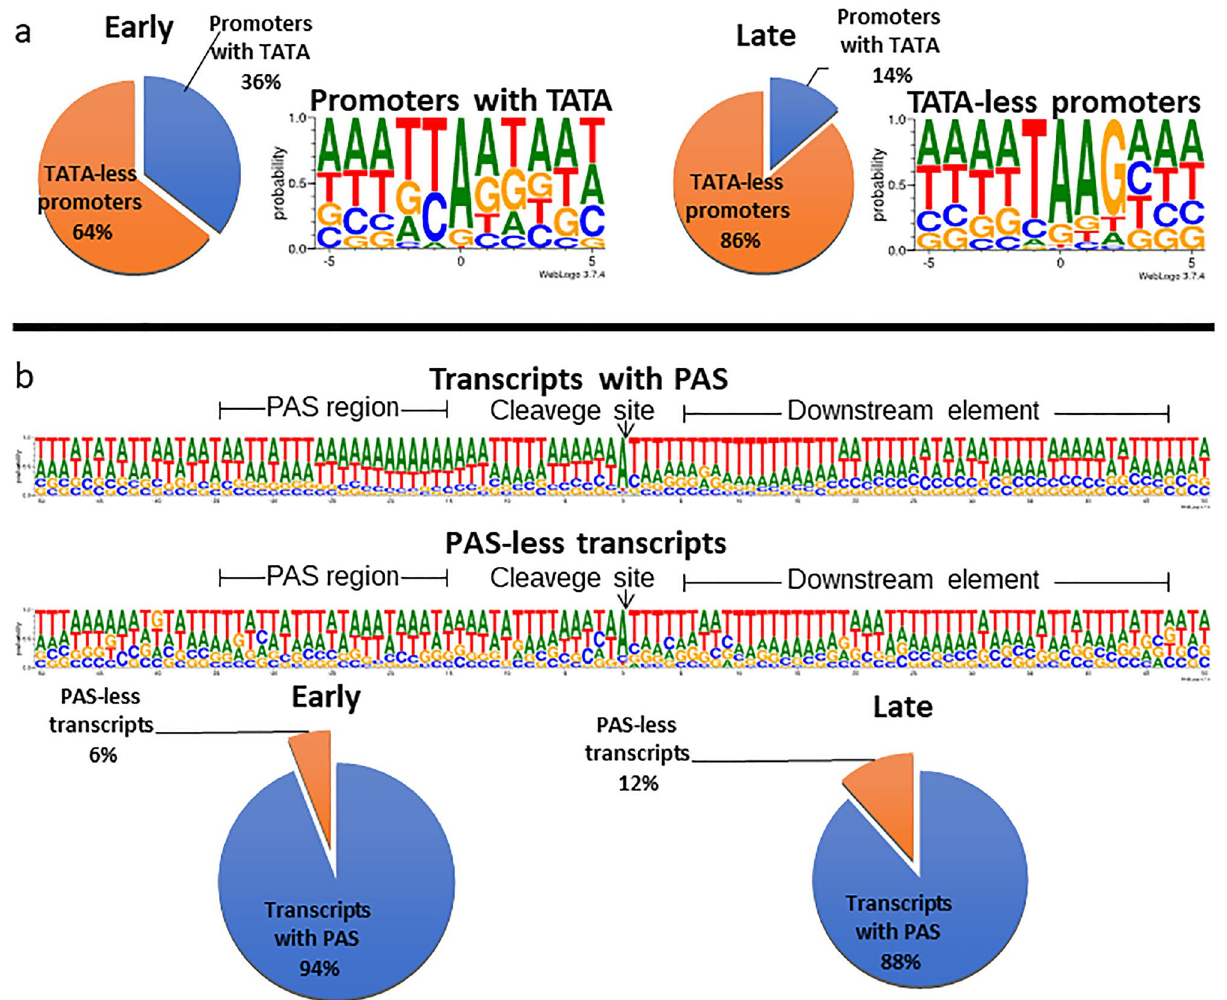
Figure 2. Utilization of TATA box and polyadenylation signal (PAS) in early and late viral transcripts. ( a ) The pie charts show the percentage of TATA (blue) and non-TATA (orange) promoters for early (5 m, 1 h, 2 h, 4 h, and 6 h) and late (16 h, 24 h, 48 h, and 72 h) time points. The pie chart was created with Microsoft Excel 2021 software 48 . ( b ) The weblogo shows the probability of the occurrence of TSSs and nucleotides in their genomic environment. The weblogo shows the poly(A) signal in the downstream element and the probability of occurrence of nucleotides in their vicinity. Pie charts for early (5 m, 1 h, 2 h, 4 h, 6 h) and late (16 h, 24 h, 48 h, 72 h) time points show the percentages of transcripts with poly(A) signal (blue) and without Poly(A) signal (orange). The weblogo image is generated using weblogo 3.0 49 . The pie chart was created with Microsoft Excel 2021 software 48 .